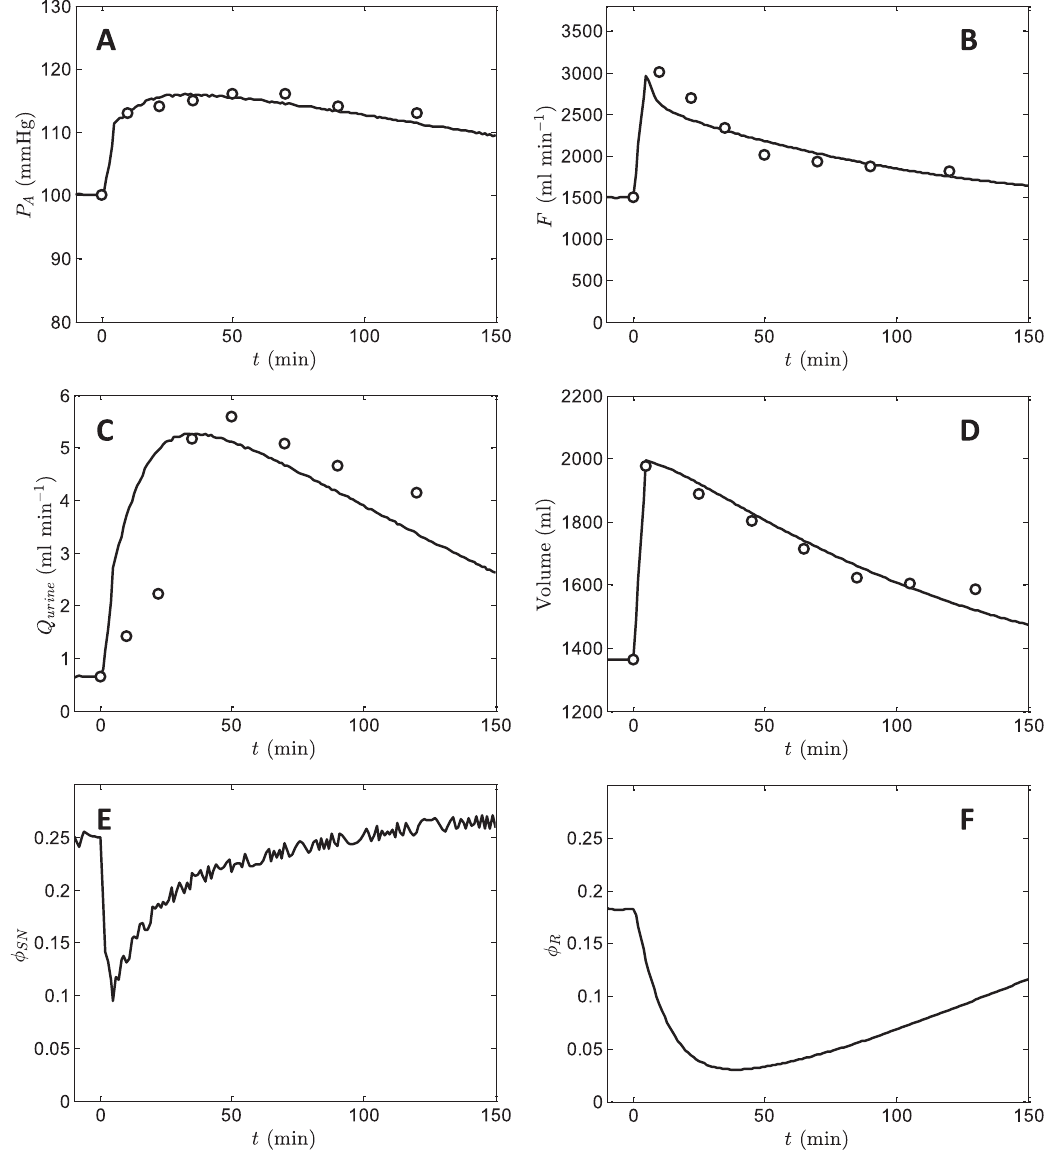
Figure 6. Simulation of arterial pressure, cardiac output, rate of urine formation, blood volume, φ , and φ following infusion of 45% SN R of initial baseline blood volume in a normal animal. Data on arterial pressure, cardiac output, rate of urine formation, and blood volume are obtained from Dobbs et al. 18 , Guyton et al. 1 , and Prather et al. 19 . The initial steady state of the model was obtained based on a constant infusion of Q = 0.5835 ml min -1 . For times 0 < t < 5 min, Q was set to 0.5835 + 126.82 ml min -1 , to result in a total excess volume of 634 ml. in in The initial condition for the simulation was obtained by setting Q = 0.5835 ml min -1 and running the model to obtain the steady in